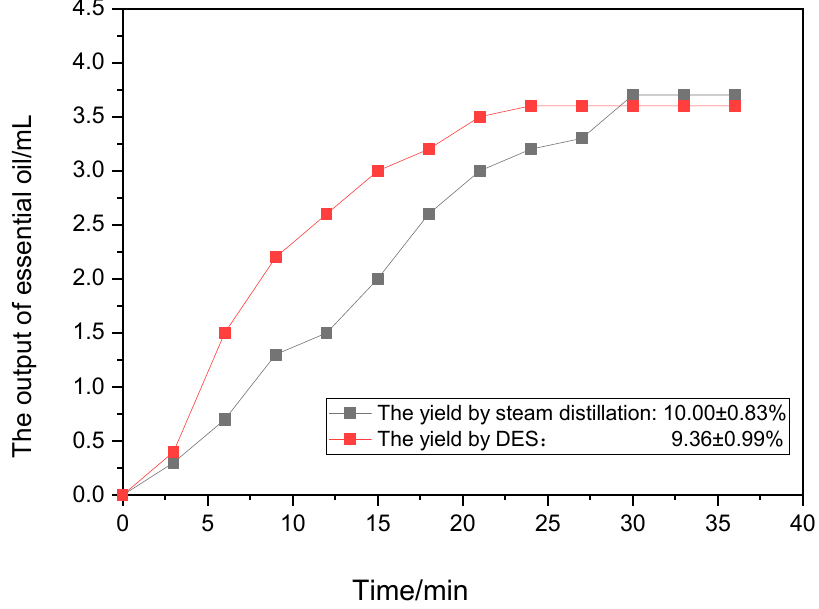
Figure 1. The output of Zanthoxylum bungeanum essential oil.